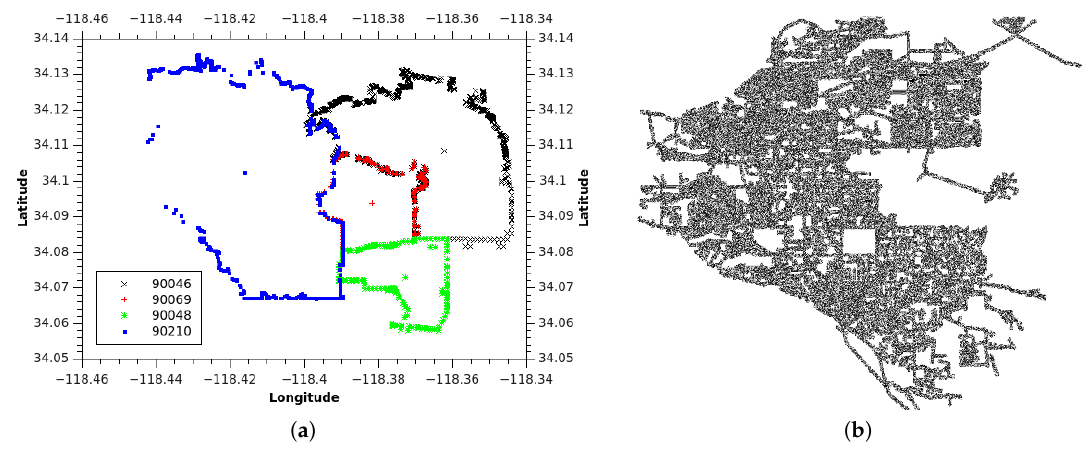
Figure 4. Raw data visualization. ( a ) ZIP code boundary; ( b ) TIGER/Line road